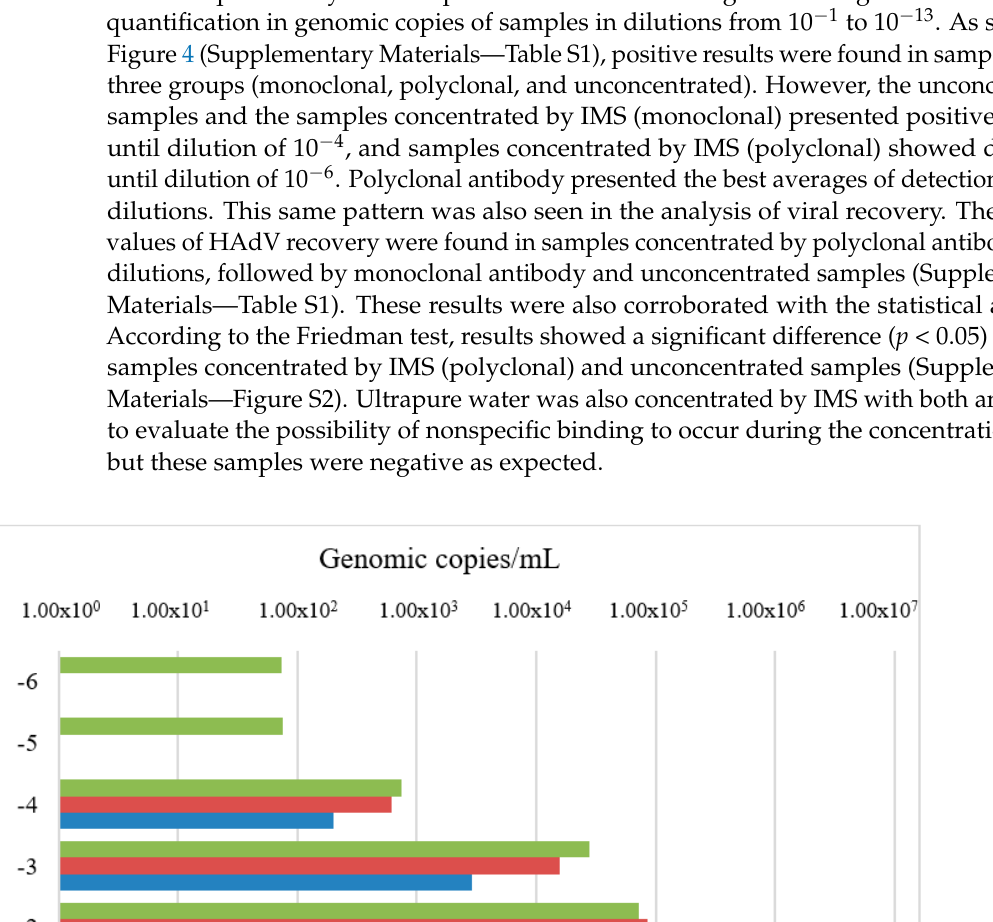
Figure 5. Detection of viral infectious particles in HAdV-5 serial dilution samples concentrated by the IMS method.